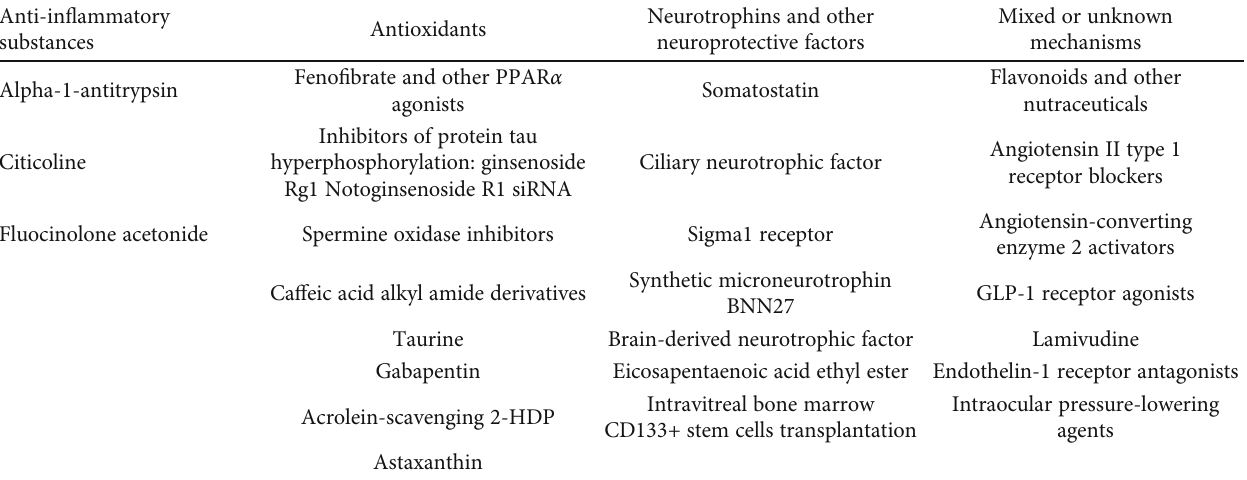
Table 1: Novel therapeutic approaches to diabetic retinal neurodegeneration in experimental